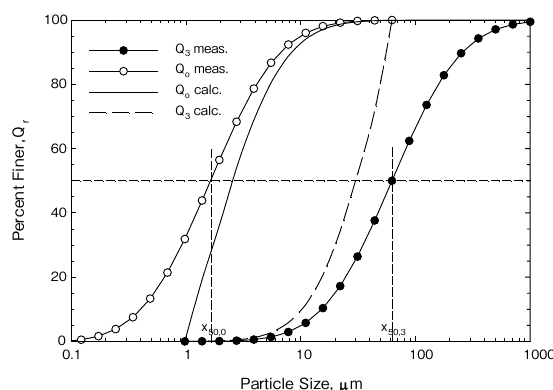
Particle Size, m Fig. A2 Effect of total number of particles counted N on transformation of number to volume distribution.